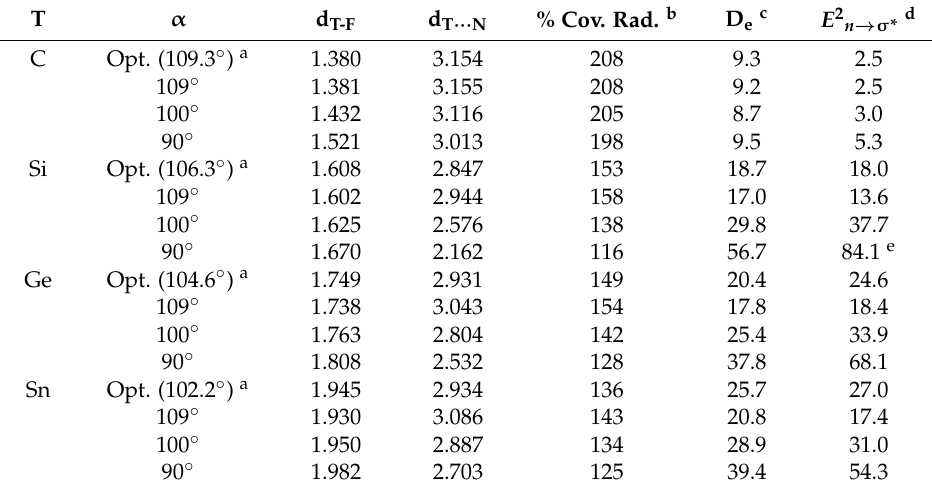
Table 2. Properties of the complexes of 1 T with HCN at different α angles: (distances in Å, energies in kJ mol − 1